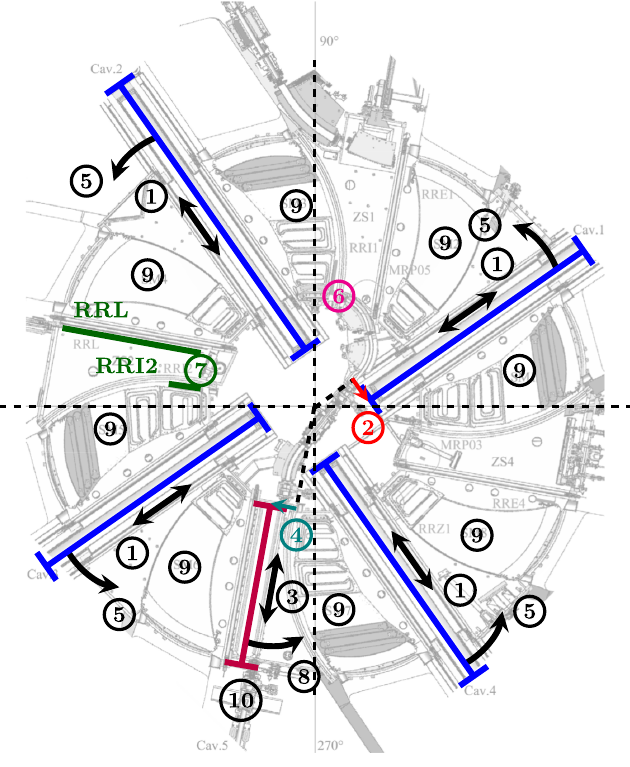
FIG. 14. Design variables in context of the PSI Ring cyclotron. In Table V is a description of each variable. Legend: ① , rmainshift1 — rmainshift4 and vmaincav1 — vmaincav4; ② , pdismain1 — pdismain4; ③ , rftshift; ④ , pdisft; ⑤ , phimain1 — phimain4; ⑥ , benergy, prinit, phiinit, and rinit; ⑦ , rrla, rrlphi, rrlshift, rri2a, rri2phi, and rri2shift; ⑧ , phift; ⑨ , tc01mb — tc16mb; 10 ○ , phirfft and